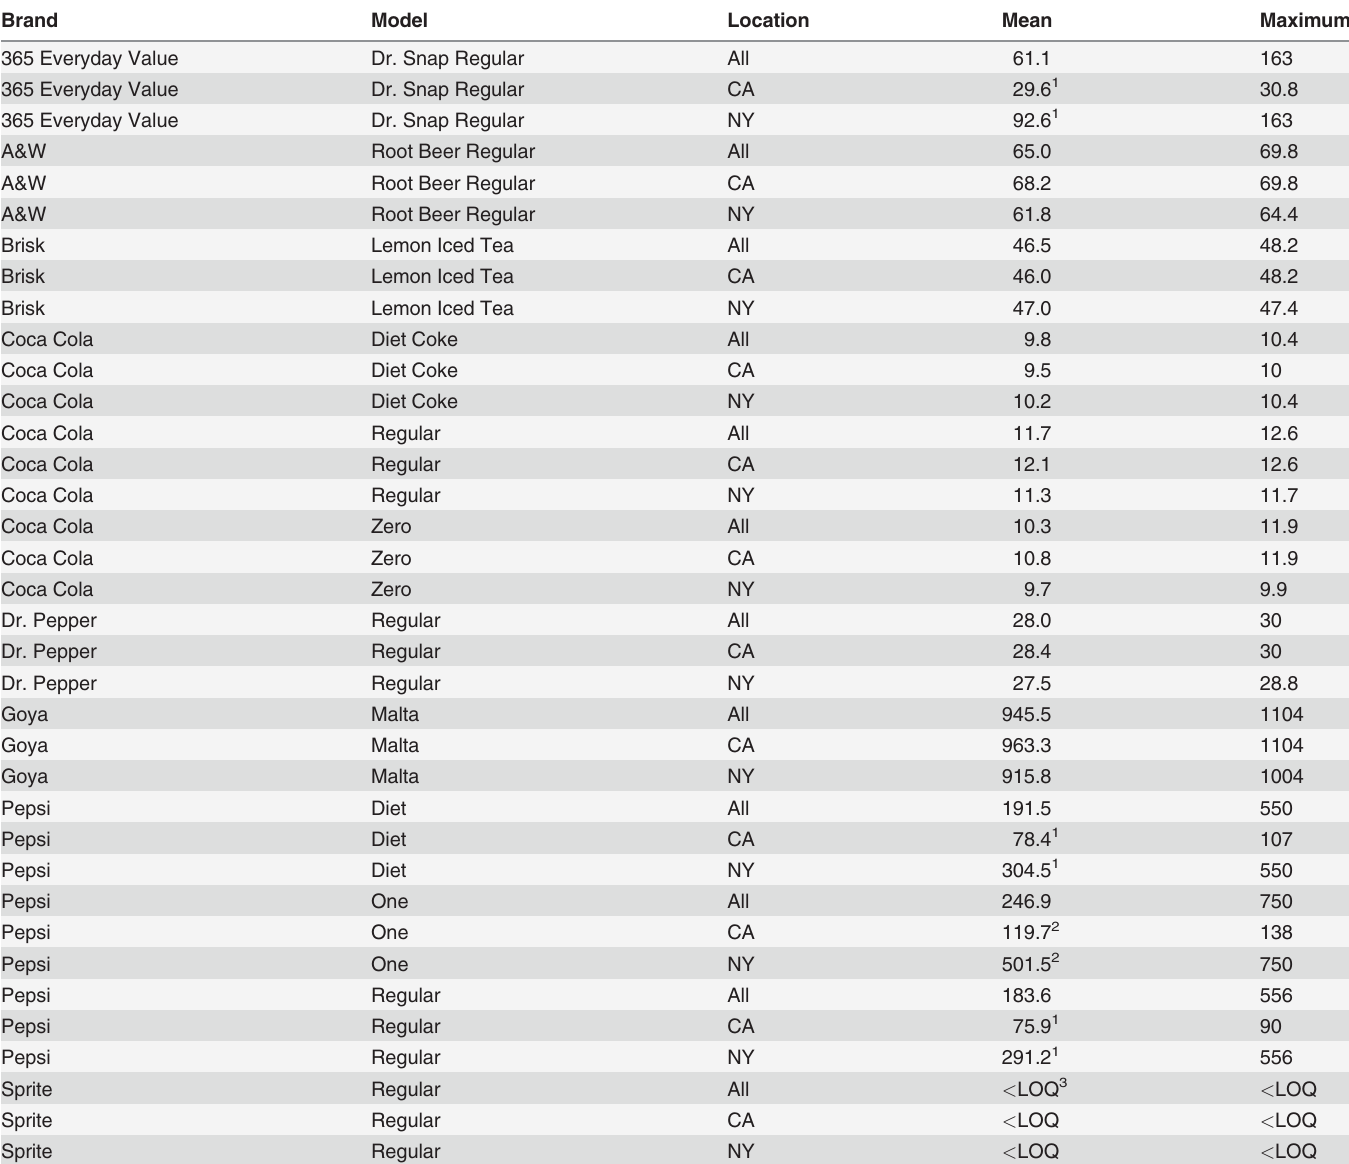
Table 1. Mean and Maximum 4-MEI Concentrations ( μ g/L) in Beverage, by Brand, Beverage, and